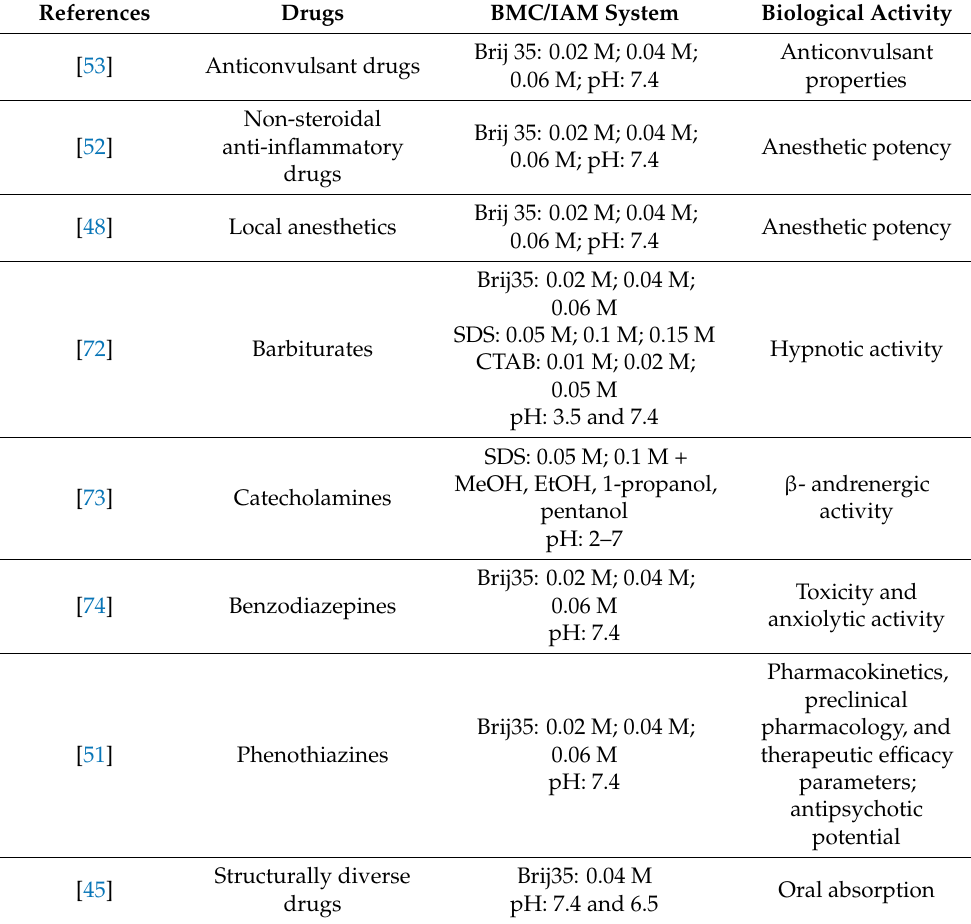
Table 1. The use of Bio-partitioning Micellar Chromatography (BMC), Immobilized Artificial Mem- brane (IAM), and cholesterol (CHOL) chromatography to evaluate the biological activity of organic